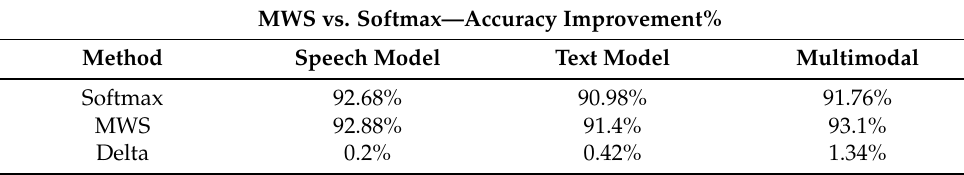
Table 5. The Table Compares the MWS method with Softmax used in Attention